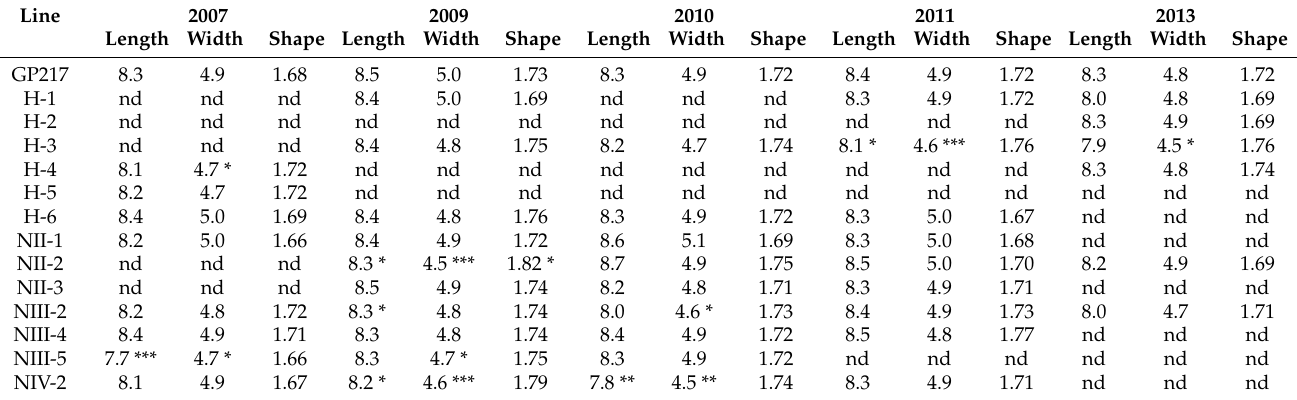
Table 3. Size (mm) and shape (length:width) of pear